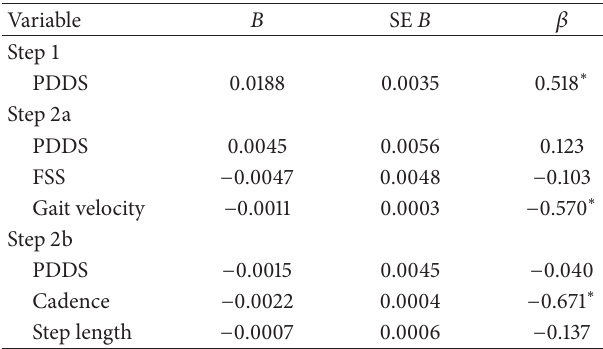
Table 3: Summary of hierarchical linear regression analyses for predicting oxygen-cost of walking in 82 persons with